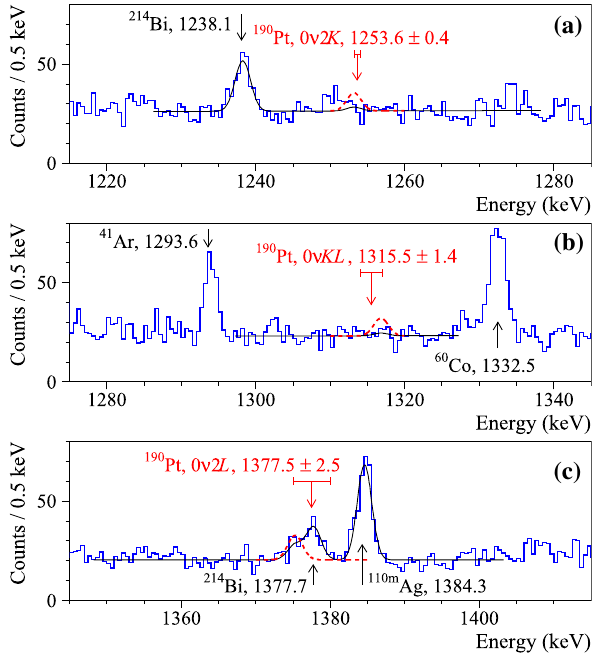
Fig. 7 The energy spectrum gathered with the Pt sample in the energy intervals where the γ peaks from the 0 ν 2 K ( a ), 0 ν K L ( b ), and 0 ν 2 L ( c ) captures in 190 Pt to the ground state of 190 Os are expected. The fits of the data are shown by solid lines (see text for details of the background models), while the excluded peaks are presented by dashed lines. The horizontal lines (above the arrows labelling the energy of the peaks searched for) show the energy intervals corresponding to the uncertainties of the expected energies of the peaks. The energy of the γ peaks are in